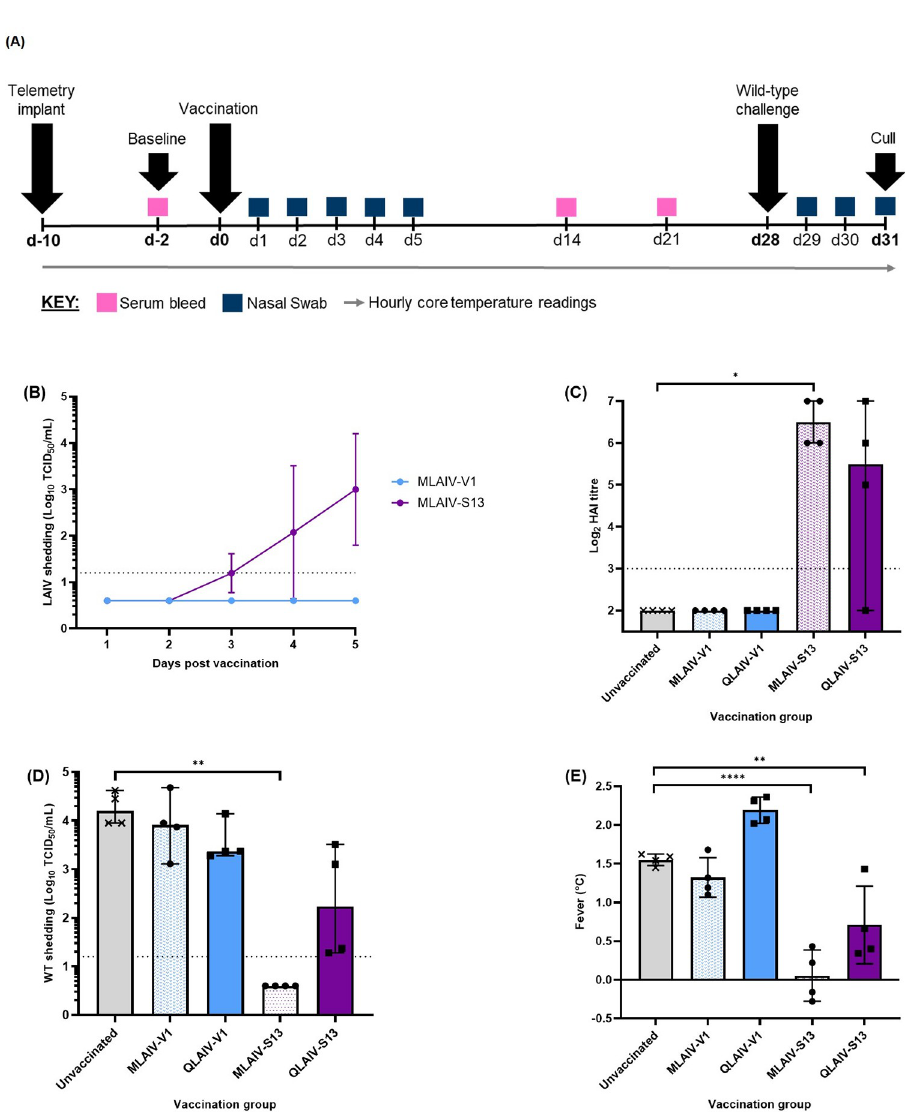
Fig 5. A/SLOV15 S13 gave superior LAIV shedding and serum immune responses and enhanced protection from wt challenge in ferrets. Groups of 4 ferrets were vaccinated with 4.0 Log 10 FFU of monovalent V1 (MLAIV-V1), monovalent S13 (MLAIV-S13), V1 in a representative 2017–18 quadrivalent formulation (QLAIV-V1) and S13 in the same representative quadrivalent formulation (QLAIV-S13). Four unvaccinated ferrets were also included as controls. (A) Schematic of 31-day optimised ferret efficacy study plan. Days are along the horizontal axis with major interventions shown by the black arrows, coloured boxes indicating sampling points and grey arrow showing hourly core body temperature readings. (B) LAIV shedding was measured by TCID 50 using nasal swab samples that were collected daily days 1–5 post vaccination. A/SLOV15 V1 and A/SLOV15 S13 shedding were compared by a paired t- test. (C) Serum immune responses were measured by HAI using antisera collected 21 days post-vaccination. MLAIV-V1, QLAIV-V1, MLAIV-S13 and QLAIV-S13 were compared to the unvaccinated control animals by performing a Kruskal-Wallis test followed by Dunn’s multiple comparisons test. (D) wt shedding was measured by TCID 50 using nasal swab samples that were collected daily between days 1–3 post wt challenge and the geometric mean of wt shedding per day for each ferret depicted by the scatter plot. Shedding of vaccinated animals relative to unvaccinated animals was compared by a Kruskal-Wallis test followed by Dunn’s multiple comparison test. (E) Ferret core body temperature was measured hourly from pre-vaccination to study termination. Fever values as a measure of influenza-like illness for individual ferrets were obtained by subtracting temperature values recorded post- wt challenge from baseline temperature for each animal. Each vaccinated group was compared to the unvaccinated control group by one-way ANOVA followed by Dunnet’s multiple comparisons test. Mean values for individual animals are depicted by the scatter plots (C-E), mean values for all animals in each vaccination group are indicated by the columns (C-E), error bars show standard deviation (B,E) or median with 95% CI (C,D), and the dotted lines represent the lower limit